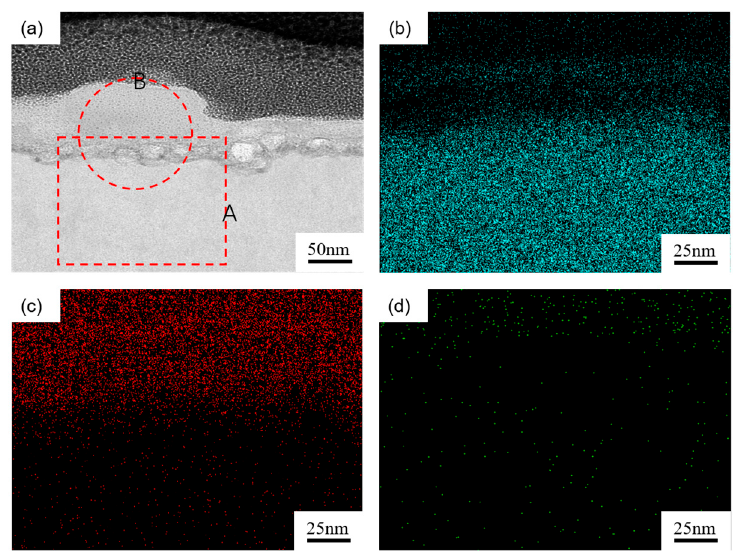
Figure 7. CNTs in Ni-CNTs/AZ91 composite materials, Mg and Mg 2 Ni distribution. ( a ): TEM micrographs; ( b – d ): EDS mapping of Mg, C, and Ni, respectively (region A).